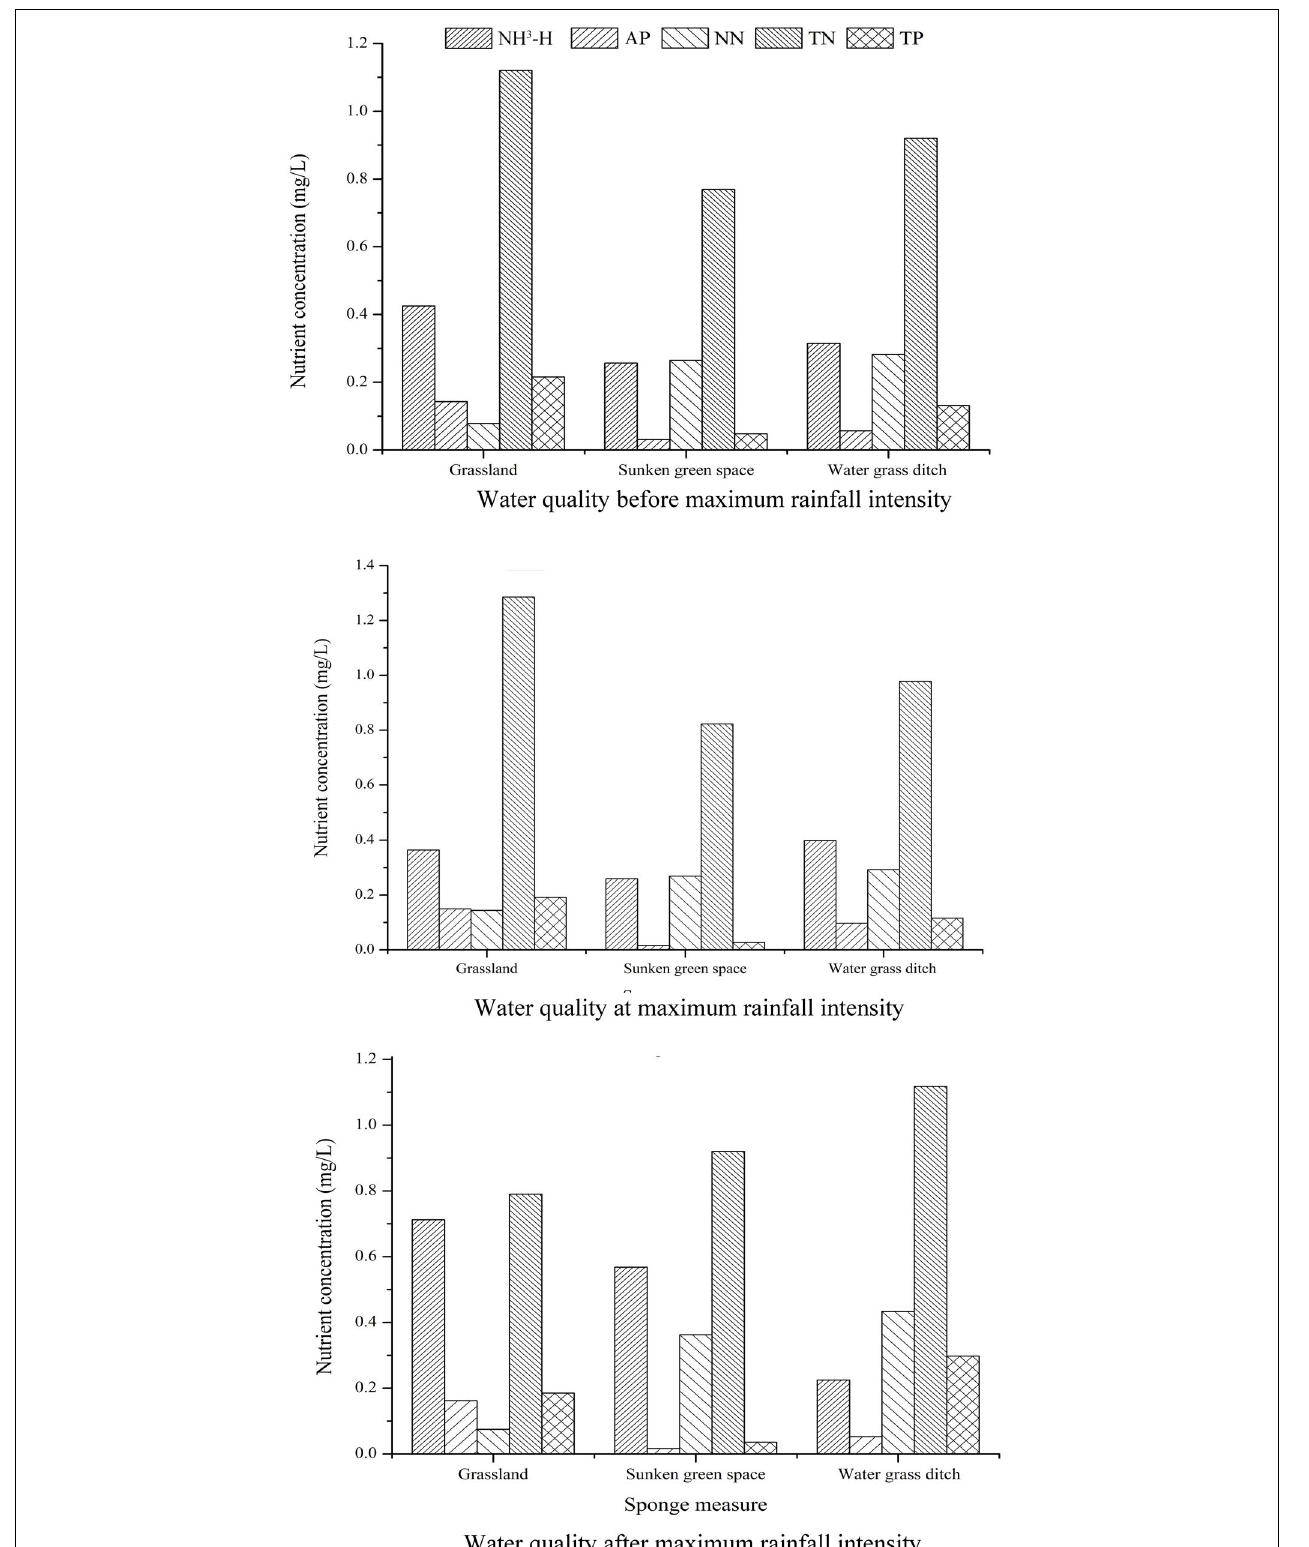
FIGURE 12 | Water quality changes in three stages during rain events.